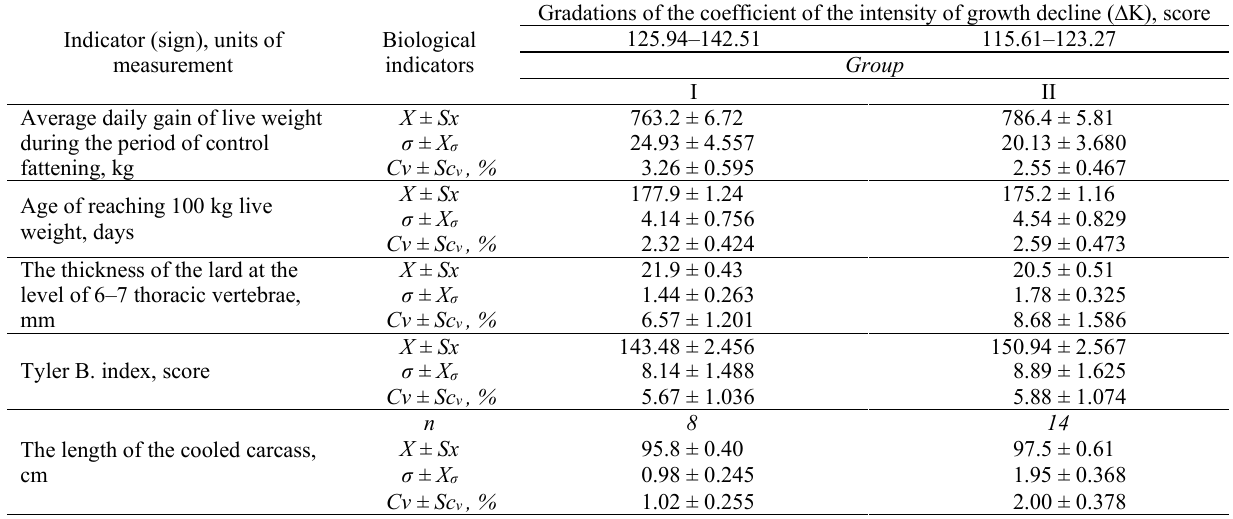
Indicator (sign), units of measurement Average daily gain of live weight during